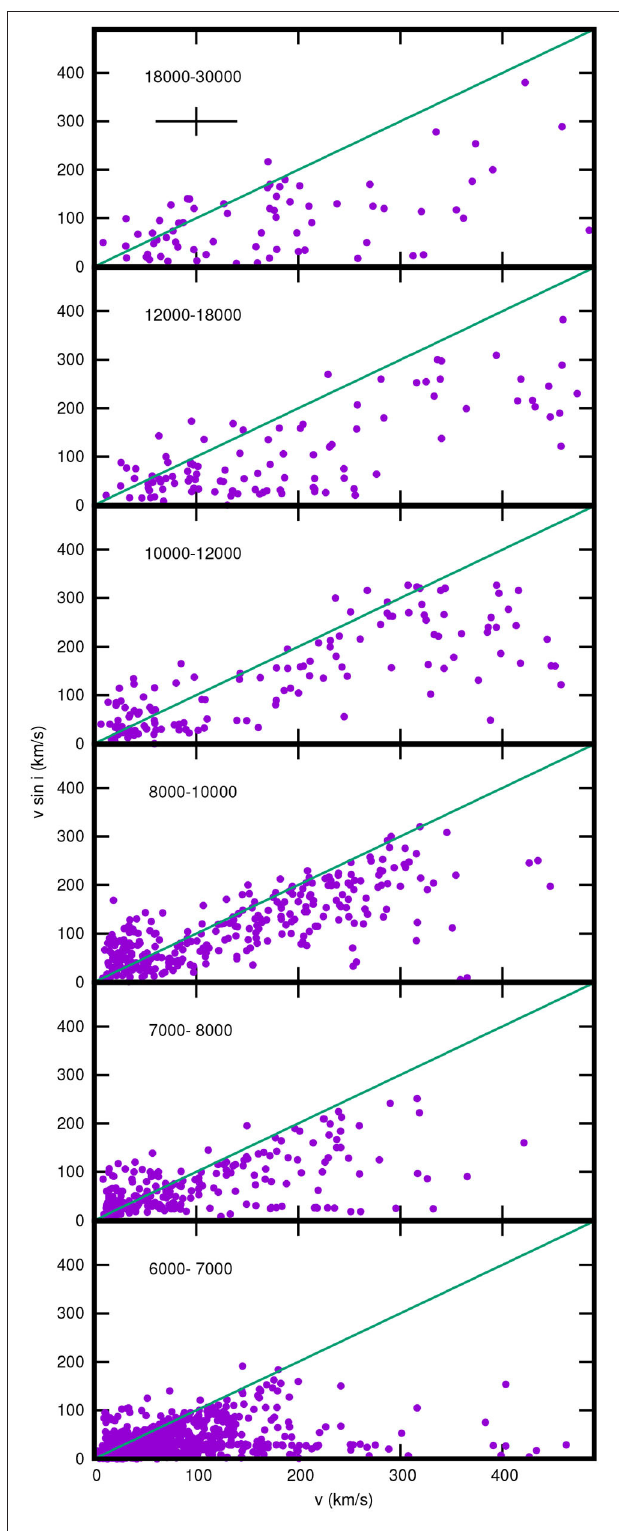
FIGURE 1 | The relationship between the projected rotational velocity, v sin i and the equatorial rotational velocity, v (estimated from the photometric frequency), for different ranges of T eff (labeled). The cross in the top left panel shows the estimated 1- σ error bars. The straight line corresponds to v = v sin i . Be stars have been